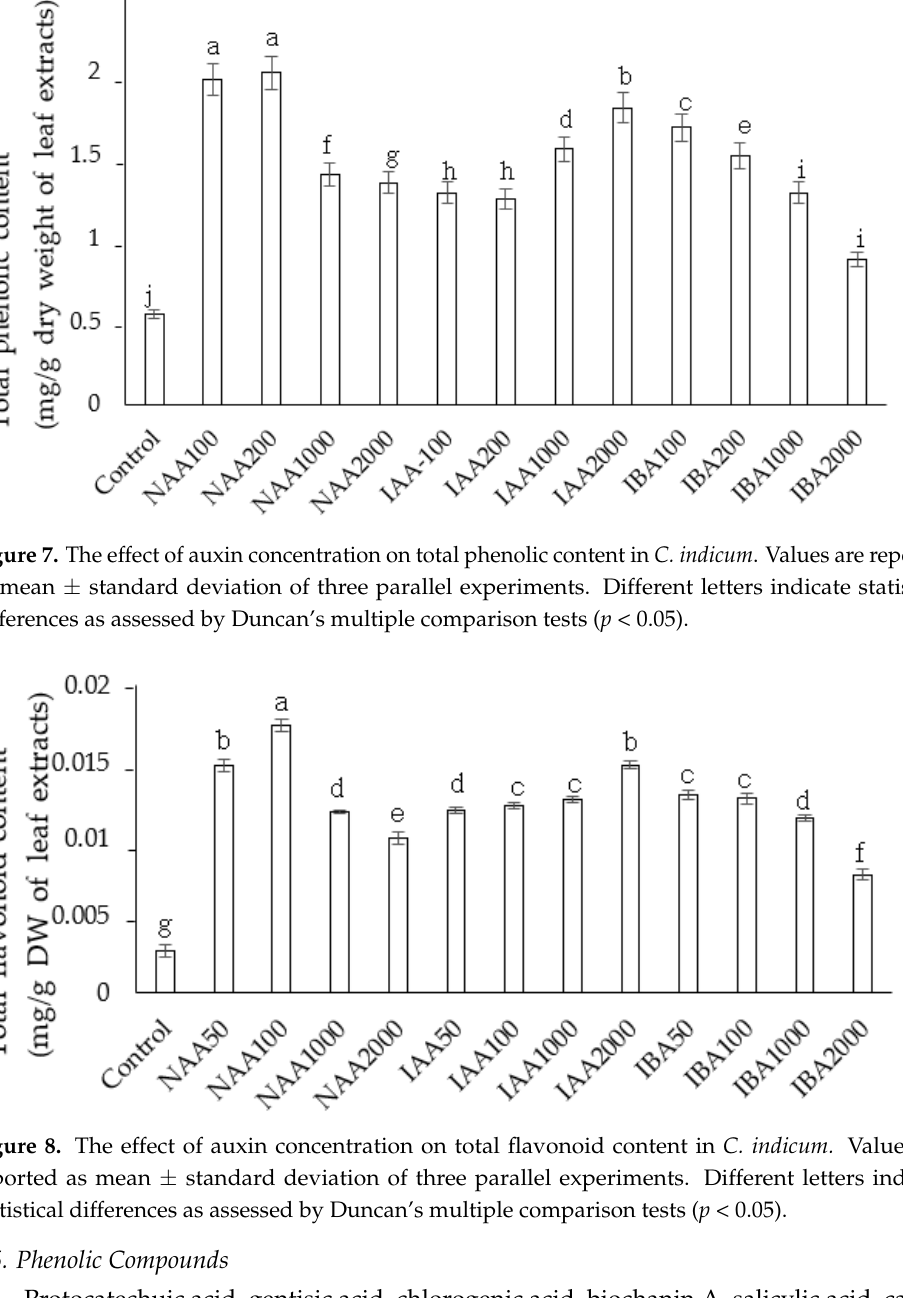
7 of 19 Figure 6. The effect of auxins on total chlorophyll content index in C. indicum. Values are reported as mean ± standard deviation of three parallel experiments. Different letters indicate statistical dif- ferences as assessed by Duncan’s multiple comparison tests ( p < 0.05). 2.5. Effect of Auxin Types and Concentration on Total Phenol Content (TPC) and Total